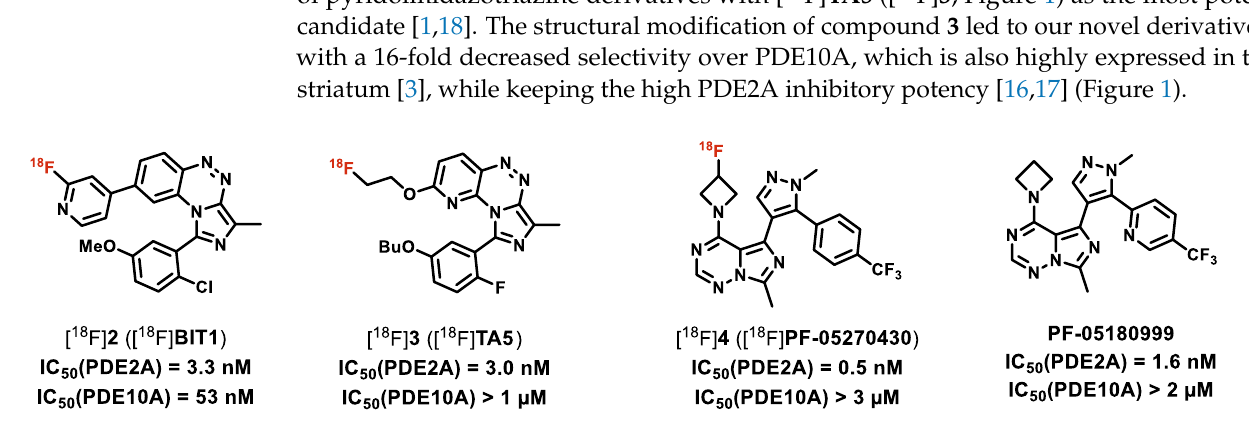
Figure 1. Molecular structures and IC 50 values for PDE2A and PDE10A of ([ 18 F]) 2 [16,17], ([ 18 F]) 3 [18], ([ 18 F]) 4 [19] and the PDE2A inhibitor PF-05180999 [20].